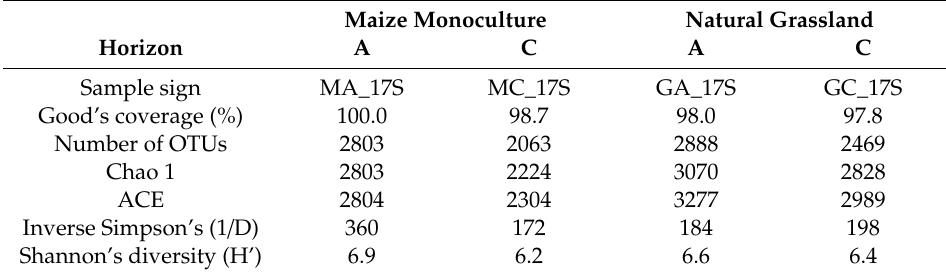
Table 2. Changes in operational taxonomic unit (OTU) richness and diversity of the studied maize monoculture and natural grassland samples.